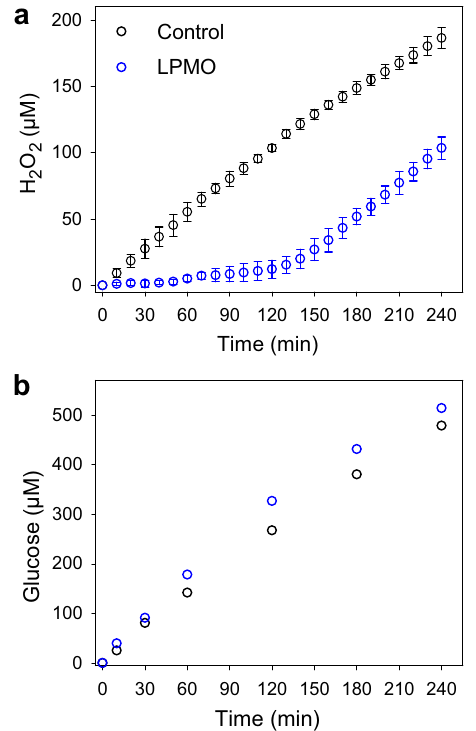
Fig. 5 | LPMO fully uses the produced H 2 O 2 in poplar wood cell walls. a Time courses of H 2 O 2 formation on wood cell walls in the presence (blue circles) and absence (black circles) of Nc LPMO9C while loading 10mgmL − 1 cellobiohydrolases and 1 µ M Ch CDH in 50mM sodium acetate buffer, pH 5.5, at 20°C. b Time courses of glucose formation on wood cell wallsin the presence (blue circles) and absence (black circles) of Nc LPMO9C while loading 10mgmL − 1 cellobiohydrolases and 2mgmL − 1 β -glucosidase in 50mM potassium phosphate buffer, pH 6.0, at 20°C. 1 µ M Nc LPMO9C with 0.5 µ M Nc CDHIIA are used inboth experiments. Data in a